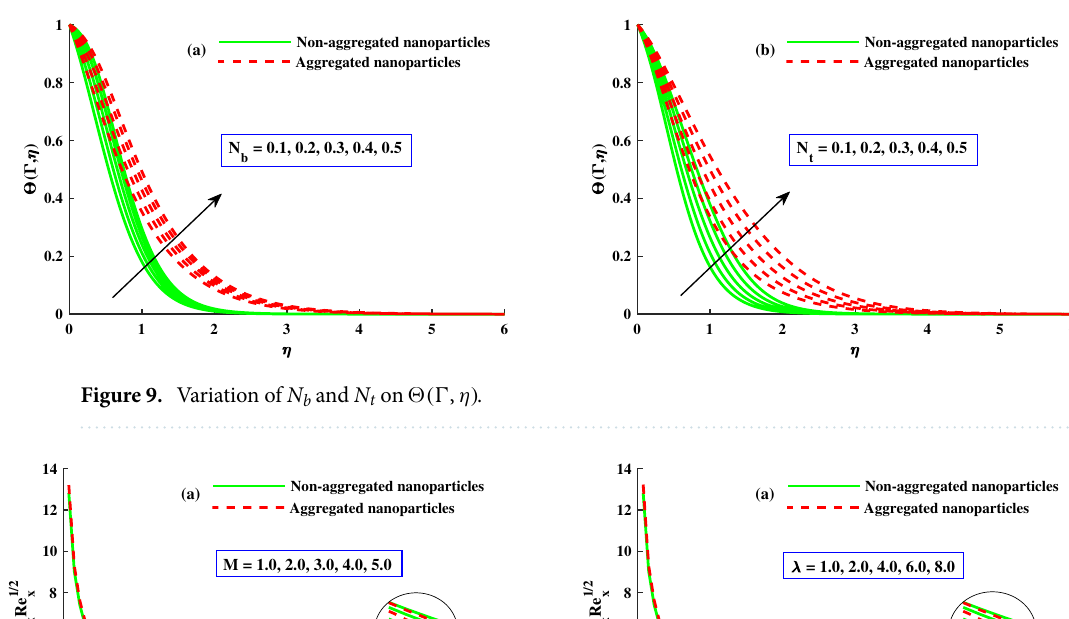
Figure 8. Variation of M and (cid:31) on �(Ŵ , η) .